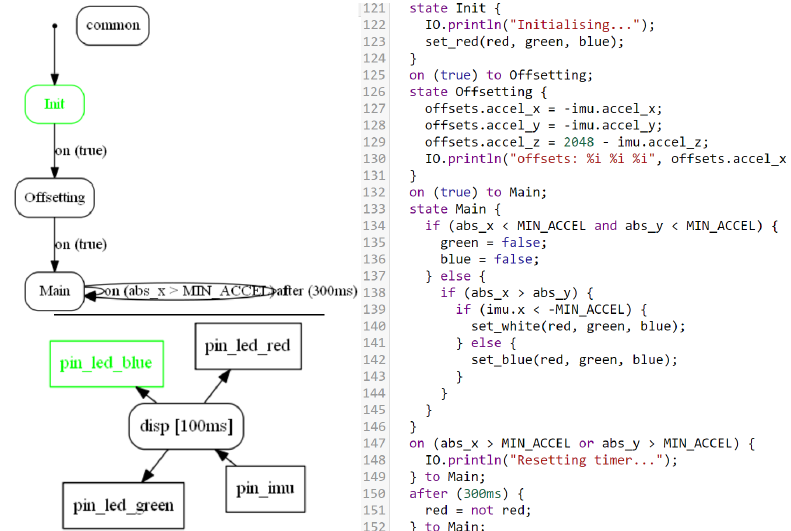
Figure 3. CPAL program illustrating the native support for FSM, conditional and timed state transitions. The top-left graphic is the representation of the FSM embedded in a process, while the bottom-left graphic is the functional architecture with the flows of data, as both seen in the CPAL-editor.